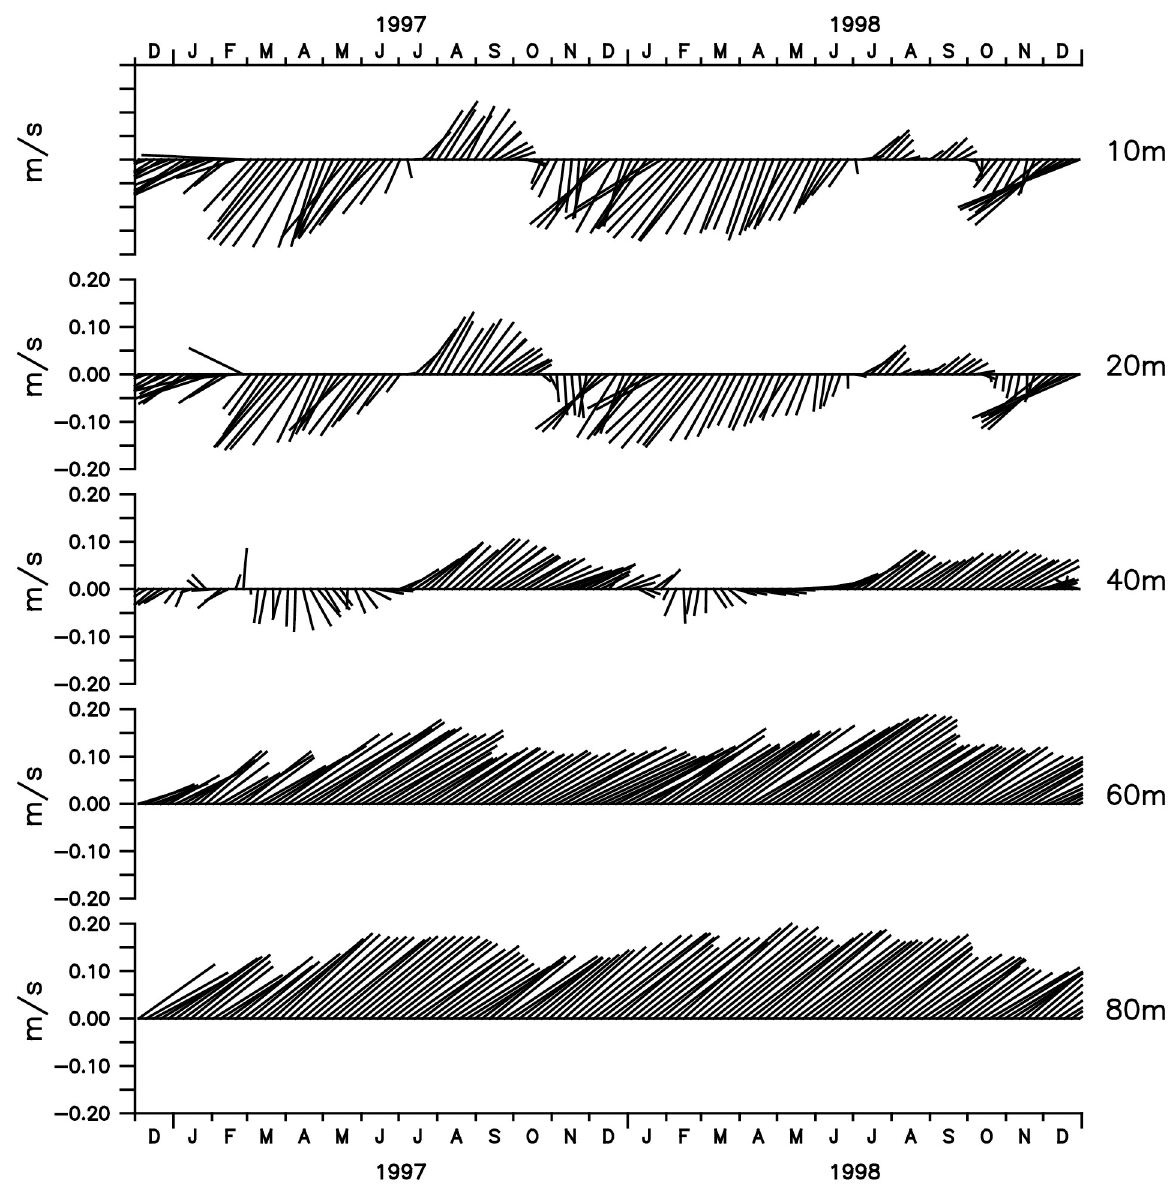
Fig 7. Velocity stick vectors at different depts at the site of the Johns et al. (2003) [3] mooring, indicated in Fig